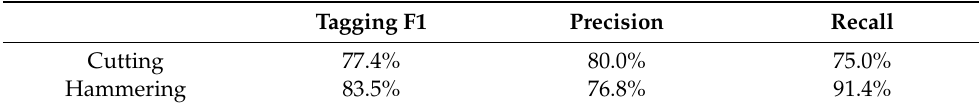
Table 6. The F1-score, precision and recall for extended experiment 1.